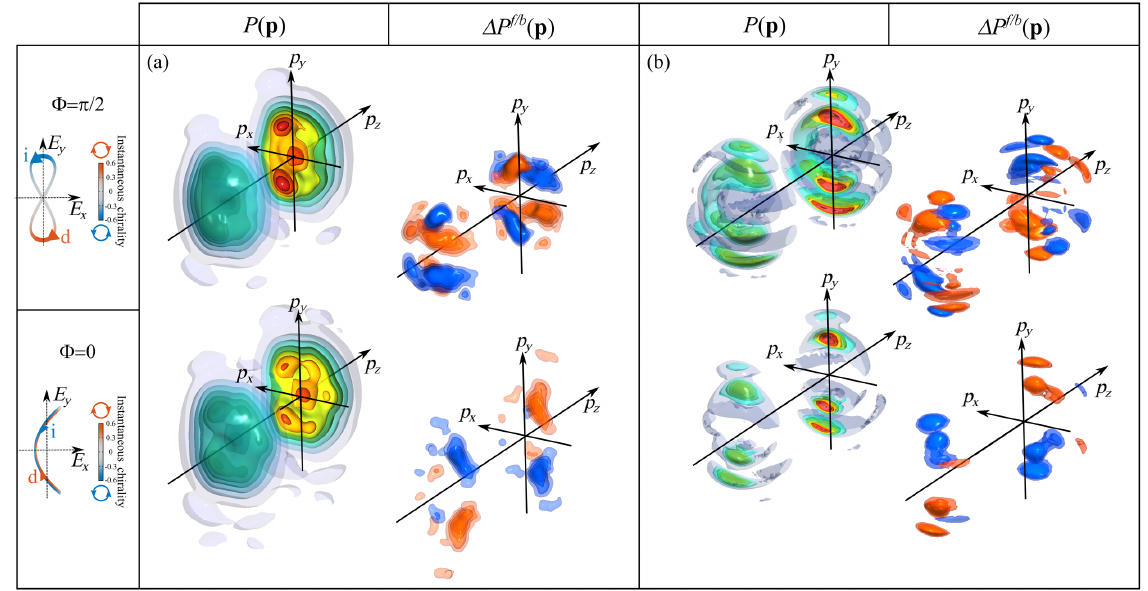
FIG. 4. Measurements (a) and calculations (b) of chiral photoionization by an OTC field. (a) Measured photoelectron angular distribution P ð p Þ and forward-backward asymmetry Δ P f=b ð p Þ from ( þ )-fenchone ionized by an OTC field with I ω ≈ 5 × 10 12 W·cm − 2 , r ≈ 0 . 1 , ϕ ¼ π = 2 (8-shaped field) and ϕ ¼ 0 ( C -shaped field). (b) Corresponding TDSE calculations in the toy-model